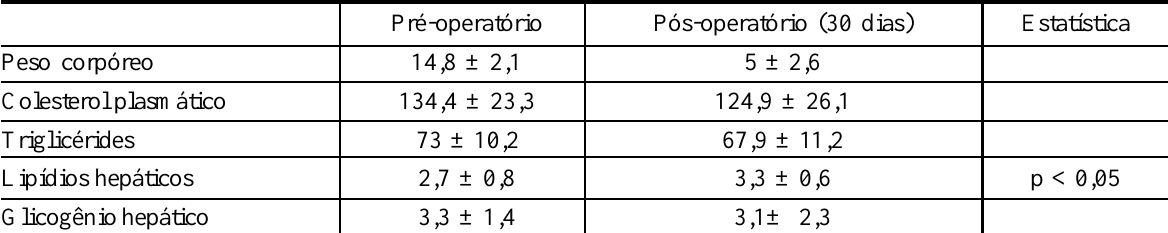
TABELA 1 - Resultados do Grupo I.